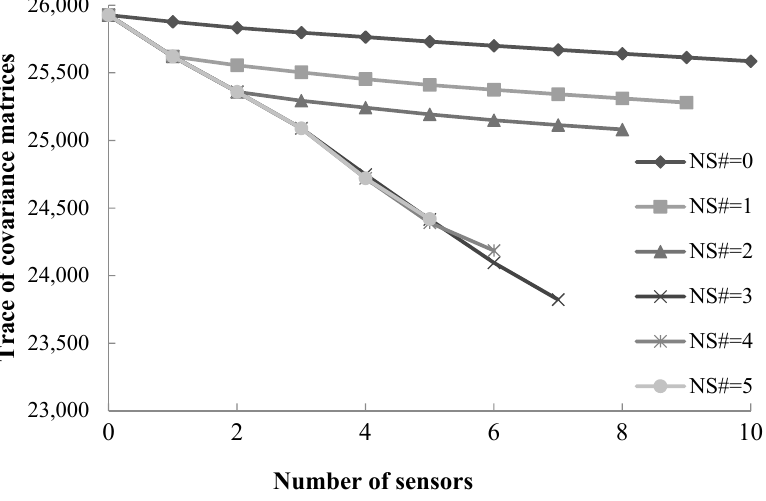
Figure 2. Traces of covariance matrices of dynamic O-D demand estimation after updating each identified sensor location with different given number of node sensors and a fixed sensor operation strategy.